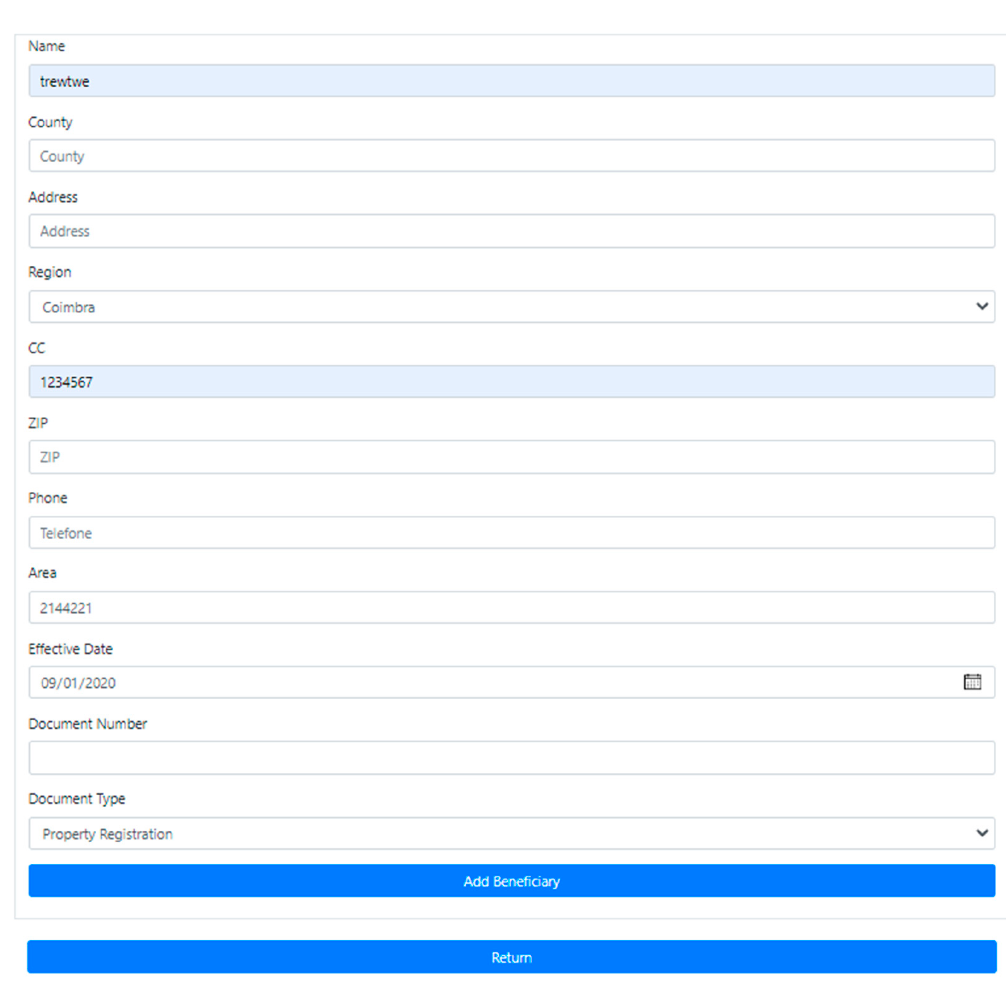
Figure 8. Beneficiary form for adding new beneficiaries.